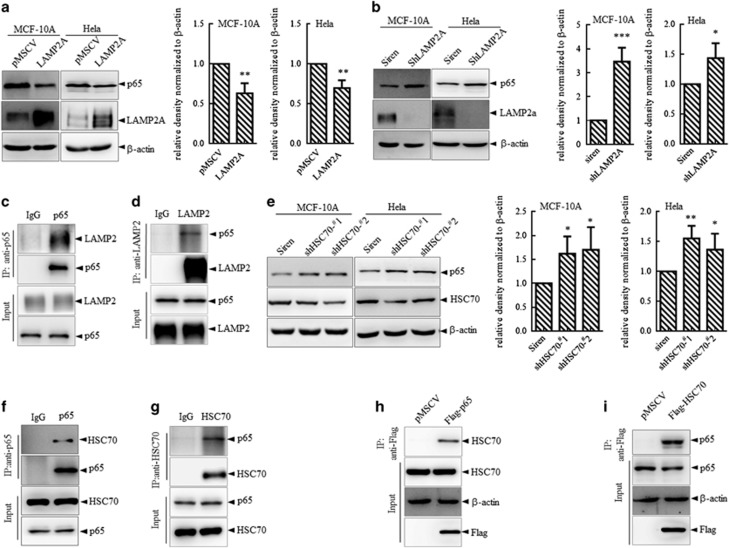
Regulation of p65 by chaperone-mediated autophagy. (a, b) MCF-10A and HeLa cells were stably infected with LAMP2A overexpression vector (a) or shRNA against LAMP2A (b) followed by immunoblots for indicated proteins. Left: representative images. Right: quantification analysis of the blot density of p65. *P<0.05, **P<0.01 and ***P<0.001 as compared with con. (c, d) Cell lysates from HEK293T cells were immunoprecipitated with anti-p65 (c) or anti-LAMP2 (d) antibodies. Precipitates were analyzed by western blots. (e) MCF-10A and HeLa cells were stably infected with two shRNAs against HSC70 followed by analysis of indicated proteins by immunoblots. Left: representative images. Right: quantification analysis of the blot density of p65. *P<0.05 and **P<0.01 as compared with the siren group. (f, g) Cell lysates from HEK293T cells were immunoprecipitated with anti-p65 (f) or anti-HSC70 (g) antibodies and precipitates were analyzed by western blots. (h, i) HEK293T cells were transfected with Flag-tagged p65 (h) or Flag-tagged HSC70 (i) and co-IP assay was performed with Flag M2 beads 48 h post transfection and followed by immunoblots for the indicated proteins.